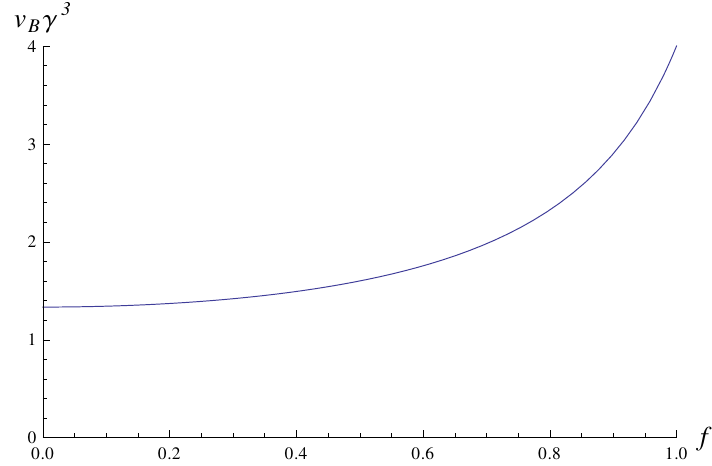
Figure 2 . Butter(cid:13)y velocity v B multiplied by (cid:13) 3 as a function of f . Here, (cid:13) is the angular size of the leaf region, and f is the fractional displacement of the bulk local operator from the tip of the HRT surface; see eq.